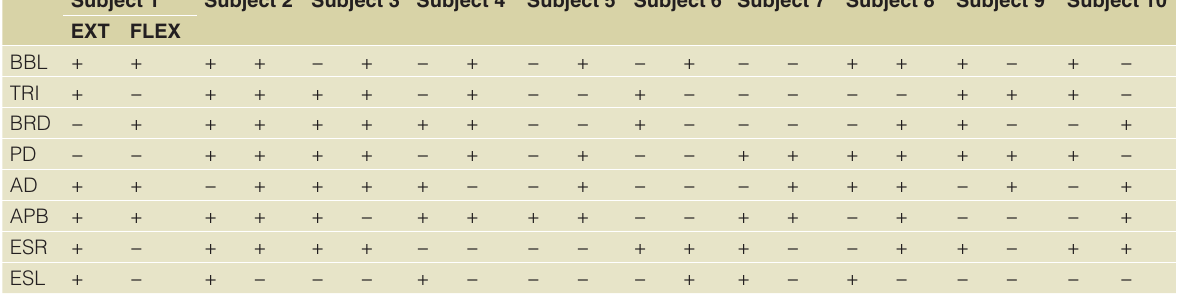
Table 1. Mean change (+ increase, - decrease) of onset latencies from the electromyography (EMG) response after EXT and FLEX practice for each muscle and all subjects. The muscles listed are the biceps brachii long head (BBL), triceps brachii (TRI), brachioradialis (BRD), posterior deltoid (PD), anterior deltoid (AD), abductor pollicis brevis (APB), right erector spinae (ESR), and left erector spinae (ESL).